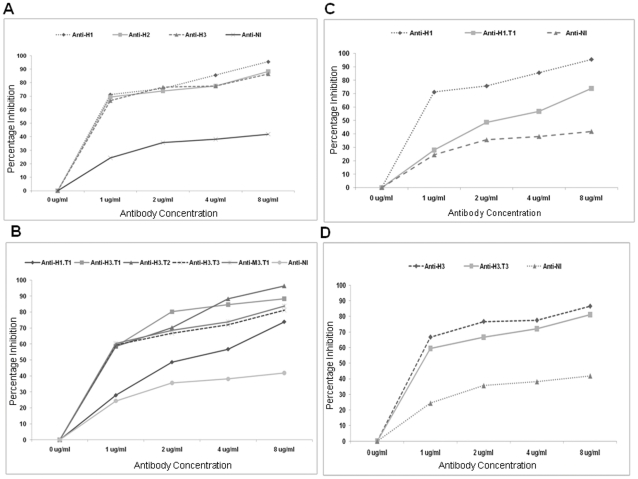
The inhibition activity of anti-DBPII epitope-specific antibody to Sal I and Thai strain epitopes.(A) Human antibody specific to DBPII epitopes strain Sal I; H1, H2, H3 and NI. (B) Antibodies specific to DBPII epitopes Thai strain; H1.T1, H3.T1, H3.T2, H3.T3, M3.T1 and NI. The purified antibodies were test to determine their inhibitory function against DBPII Sal I binding Duffy positive erythrocyte. The symbol indicates the mean percentage of inhibition of three experiments compared to the result of control experiment with no antibody. For antibody concentration of 8 ug/mL, the P value was <0.001 for comparison of H and NI peptides. Significance of inhibition was measured with the 50% inhibition concentration (1–2 µg/mL) of purified anti- H1, H2, H3 antibodies. (C) Anti-H1 compared with anti-H1.T1; (D) Anti-H3 compared with anti-H3.T3. Antibodies were tested to determine their inhibitory function against DBPII Sal I binding Duffy positive erythrocyte. The symbol indicates the mean percentage of inhibition of three experiments compared to the result of control experiment with no antibody. For antibody concentration of 8 ug/mL, the P value was <0.001 for comparison of H and NI peptides, and comparison H1.T1, H3.T3 and NI peptides.